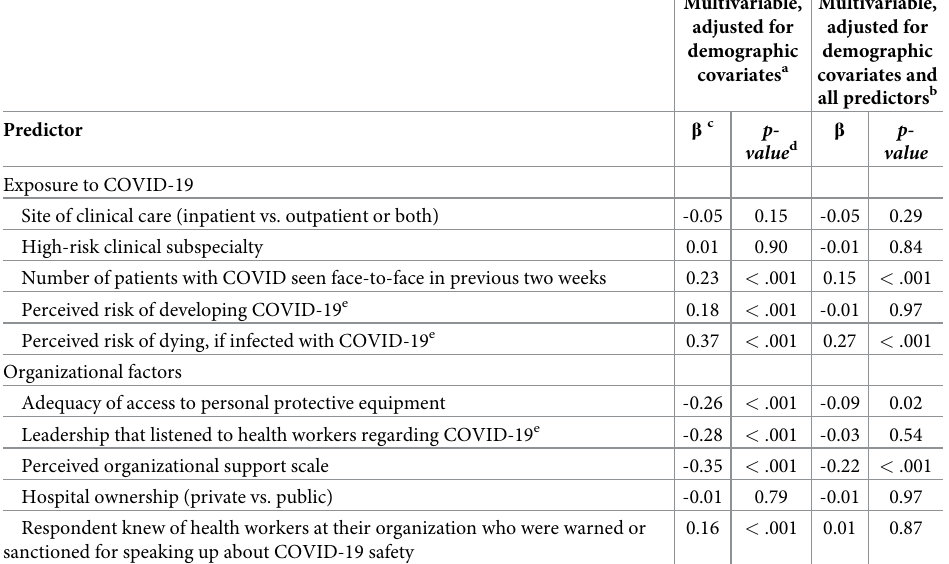
Table 1. Associations between predictors and moral